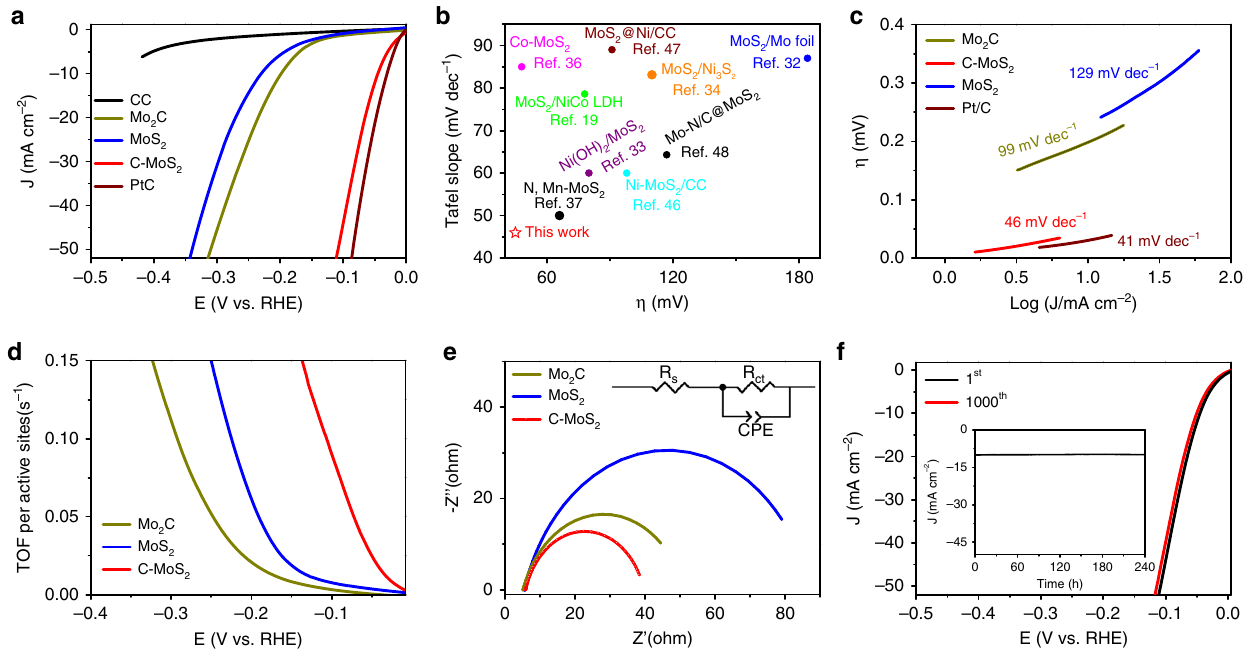
Fig. 4 Alkaline HER catalysis of C – MoS 2 . a The LSV curves of CC, Mo 2 C, C – MoS 2 , MoS 2 , and Pt/C with IR correction. b Performance comparison of C – MoS 2 with the ever-reported MoS 2 -based catalysts in alkaline condition. c The corresponding Tafel slopes. d The potential-dependent TOF curves of Mo 2 C, MoS 2 , and C – MoS 2 . e Nyquist plots of Mo 2 C, MoS 2 , and C – MoS 2 collected at the potential of 100 mV vs. RHE. f The initial and 1000 th polarization curves of C – MoS 2 . The inset is the chronoamperometric curve recorded at − 0.1 V vs. RHE without IR correction for a continuous 240